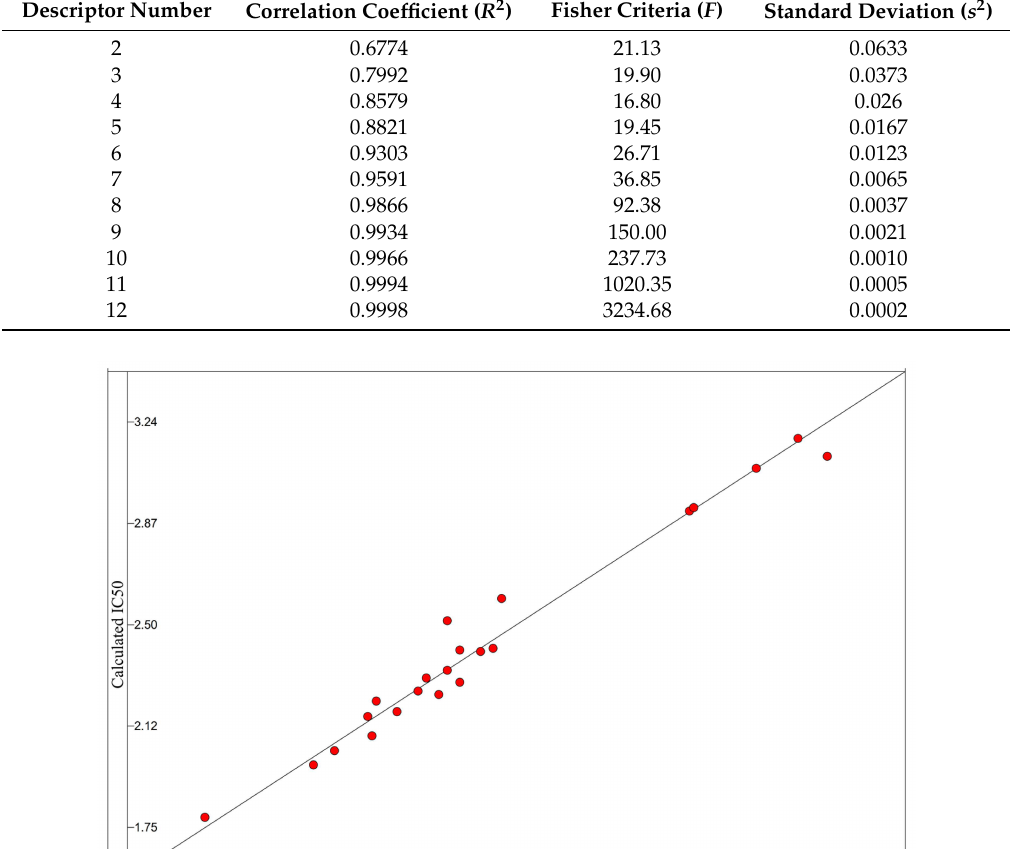
Table 2. The best two to twelve descriptors correlation using the (Best Multi Linear) BML method for training set data.